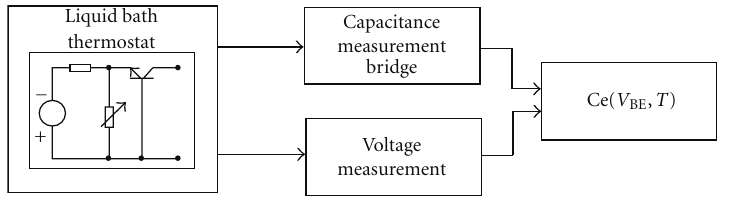
Figure 1: Measurement setup.